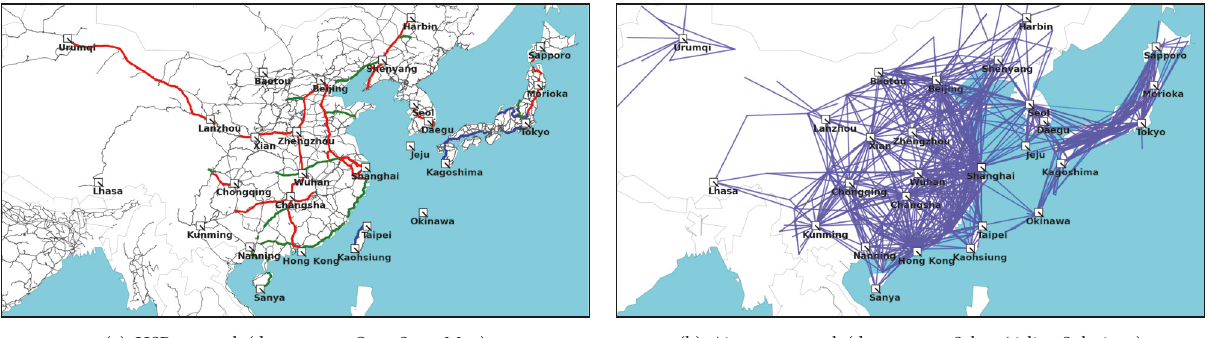
Figure 4: Comparison of HSR networks and airport networks in three Asian countries (China, Japan, and Korea). In the HSR networks, different colors indicate different maximum speed: green color > 200 km/h; blue color > 250 km/h; red color > 300km/h. In the airport networks, domestic flights with passengers more than 1,000 per month and with distances less than 1,000 km are shown. Similar with the situations in Europe, highly developed air transport networks are much denser than newly emerged HSR